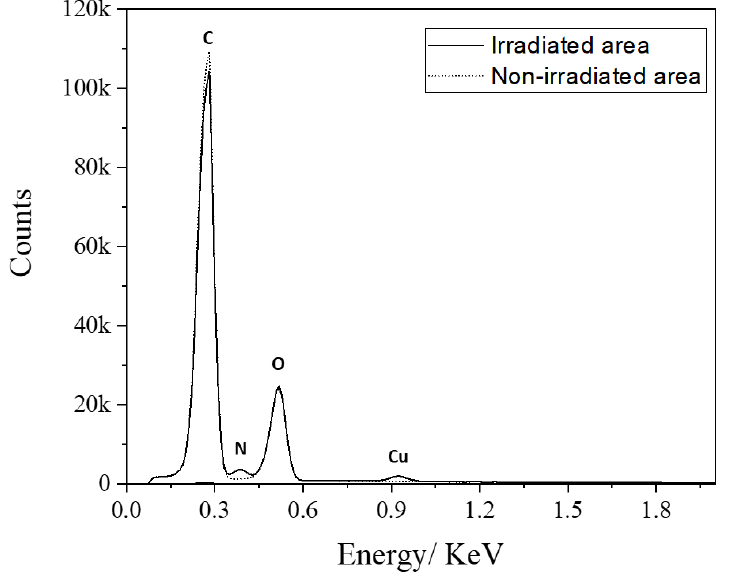
Figure 10. X-ray spectra of the Cu – PEI complex on the irradiated area (solid line) and non-irradiated area (dotted line). Table 5. EDS analysis a results of Cu – PEI complex.